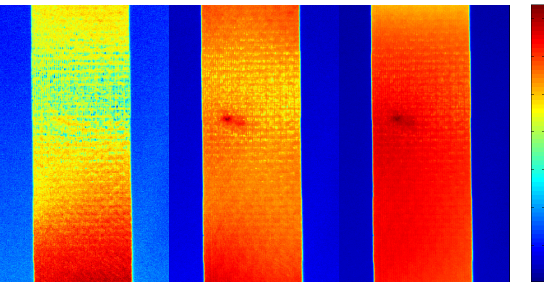
Figure 5. Example of a series of acquired thermo- graphs showing heating of the damaged zone during cyclic loading at 1 s (left), 32 s (middle) and 200 s (right); temperature scale is in ◦ C .